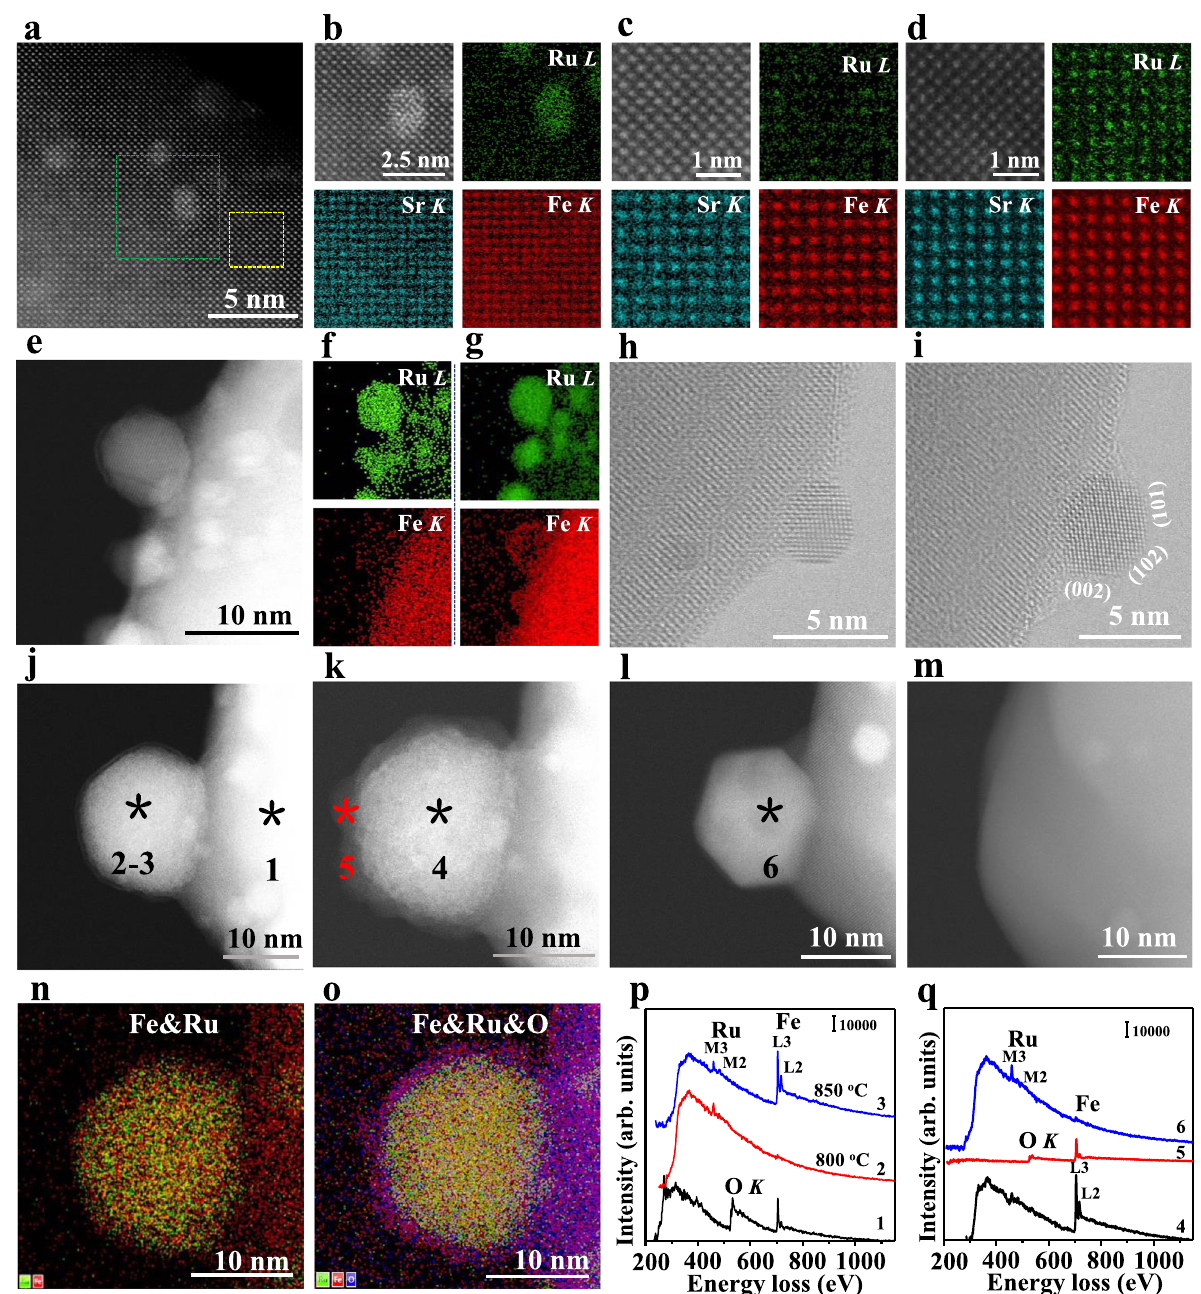
Fig. 2 In situ STEM, STEM-EDS, and STEM-EELS results. a HAADF-STEM image of SFRuM R1 and the atomic-scale elemental maps, circled with a green dotted line b and a yellow dotted line c (010). d HAADF-STEM image of SFRuM O1 and the atomic-scale elemental maps (010). e In situ DF-STEM image and STEM-EDS elemental maps of SFRuM at 800 °C for ~15 min ( f ) and then at 850 °C for ~15 min (g). In situ BF-STEM images after reduction at 800 °C for ~15 min ( h ) and then at 850 °C for ~15 min ( i ). In situ DF-STEM images of SFRuM after reduction at 800 °C for ~60 min and 850 °C for ~30 min ( j ), after reoxidation at 200 °C for ~70 s ( k ), after reoxidation at 800 °C for ~30 min ( l ), and after reoxidation at 800 °C for ~60 min ( m ). n , o The STEM-EDS elemental maps of j and k . p , q In situ STEM-EELS spectra in j – l